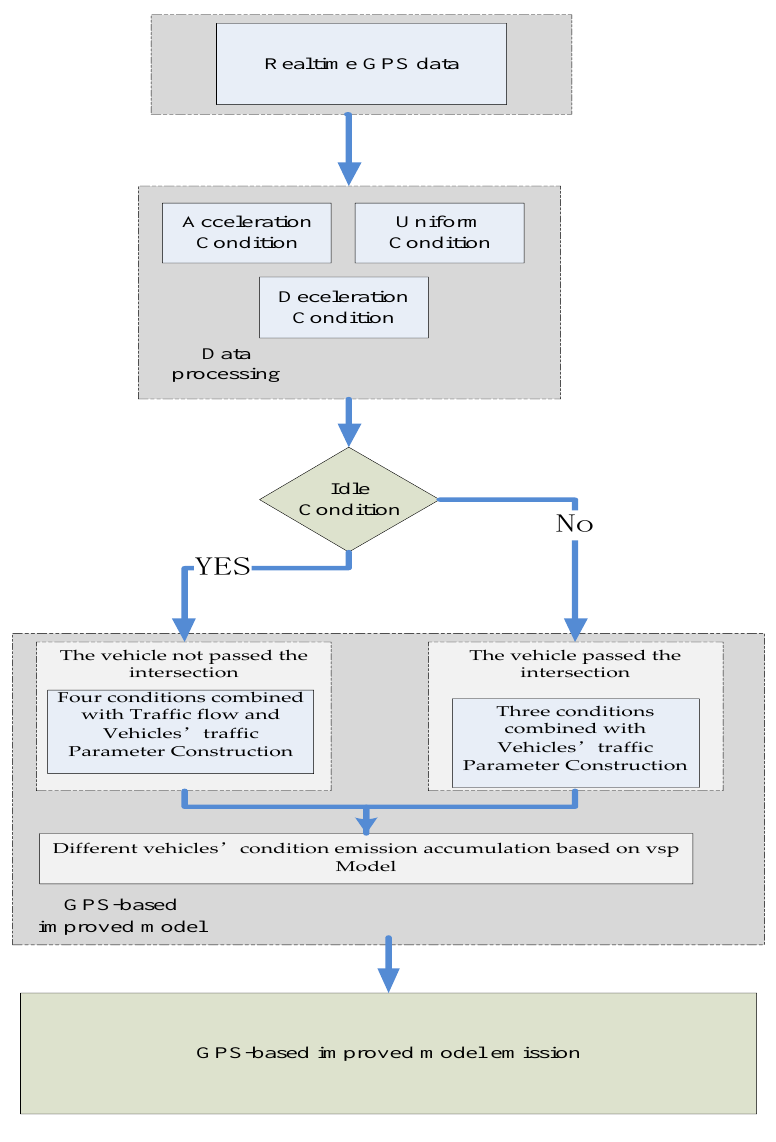
Figure 3. GPS-based improved model’s flow chart.